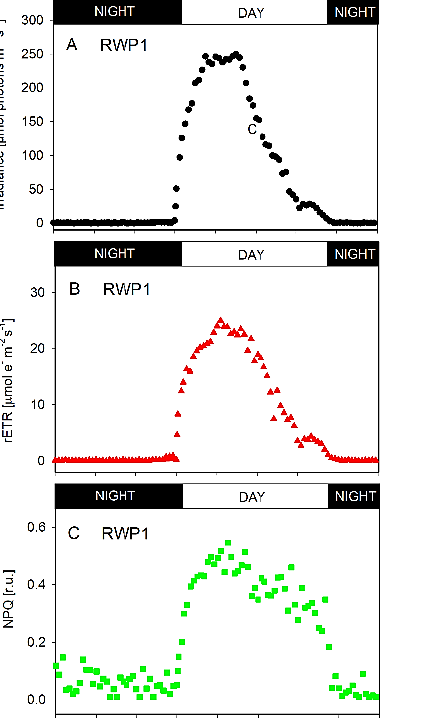
Figure 4. Diurnal changes of irradiance and photosynthetic activity (estimated in-situ /online in the photic zone) in the microalgae culture grown outdoors in the RWP1 ( left panels ) and RWP2 ( right panels ) bioreactors. ( A ) Irradiance intensity in the culture measured in the photic zone (the depth of light penetration); ( B ) relative electron transport rate rETR = [YII × PAR]; ( C ) non-photochemical quenching NPQ.